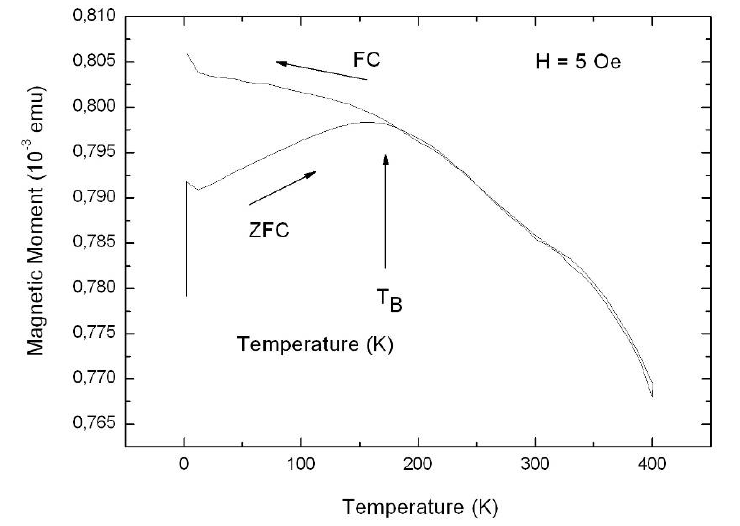
Table 5. Magnetic characteristics of a Co-filled PS-sample. The coercivities H remanence M and squareness (M /M ) are determined for both magnetization directions, R R S perpendicular and parallel to the surface